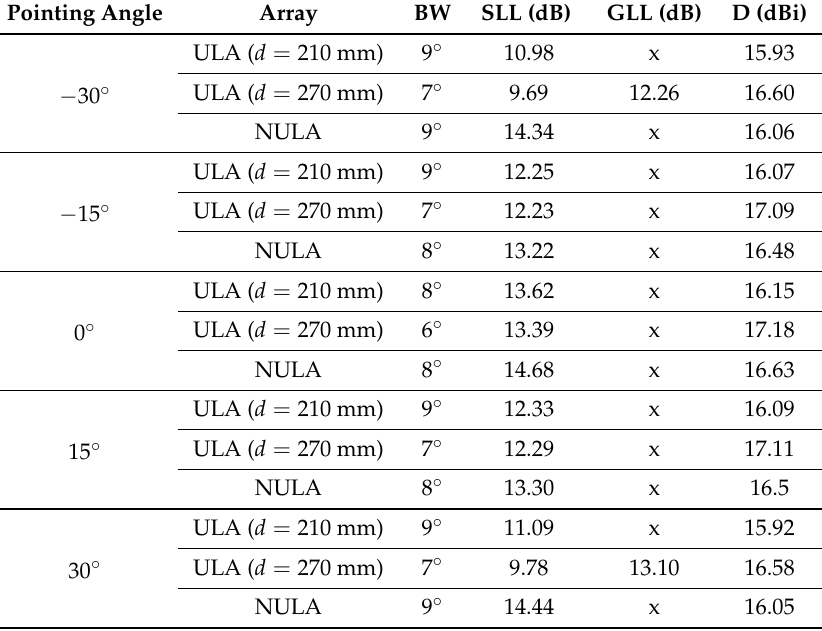
Table 5. Main characteristics of the azimuth plane radiation patterns generated with the maximum directivity weighting vector of the ULAs with inter-element spacings of 210 mm and 270 mm and the NULA designed in Section 3.2, for N = 11 commercial antennas. The considered steering angles are φ = [ − 30, − 15,0,15,30 ] ◦